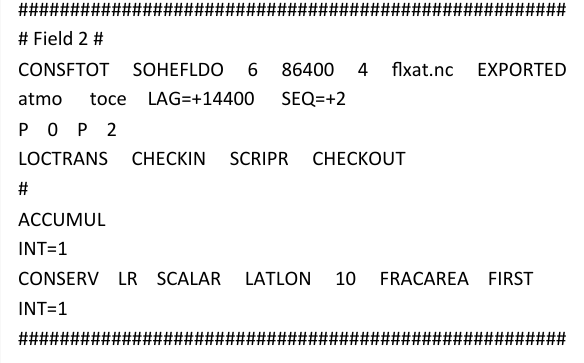
Fig. 2. Second part of the namcouple for one coupling field with source symbolic name CONSFTOT and target symbolic name SOHEFLDO . On the first line, 6 is an index used to identify corre- sponding CF standard name and units in auxiliary file, 86400 is the coupling period, 4 is the number of transformations, flxat.nc is the name of the coupling restart field, and EXPORTED is the type of the coupling field. On the second line, atmo and toce are the source and target grid acronyms; a lag of 14400 and a sequence in- dex of 2 are then specified. On the third valid line, the source and target grid characteristics are provided: the source grid is periodic ( P ) with no overlapping grid point and the target grid is also peri- odic ( P ), but with 2 overlapping grid points. On the fourth line,